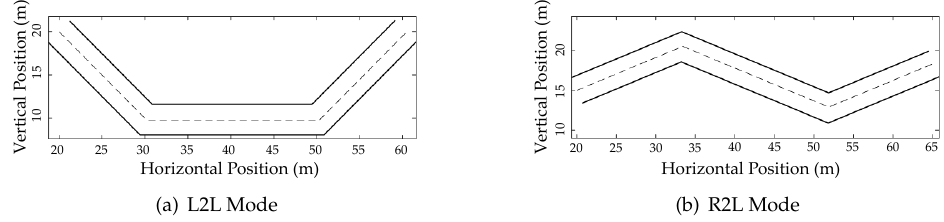
Figure 8. Typical continuous turning situations in narrow corridors with ( a ) presents the L2L mode and ( b ) presents the R2L